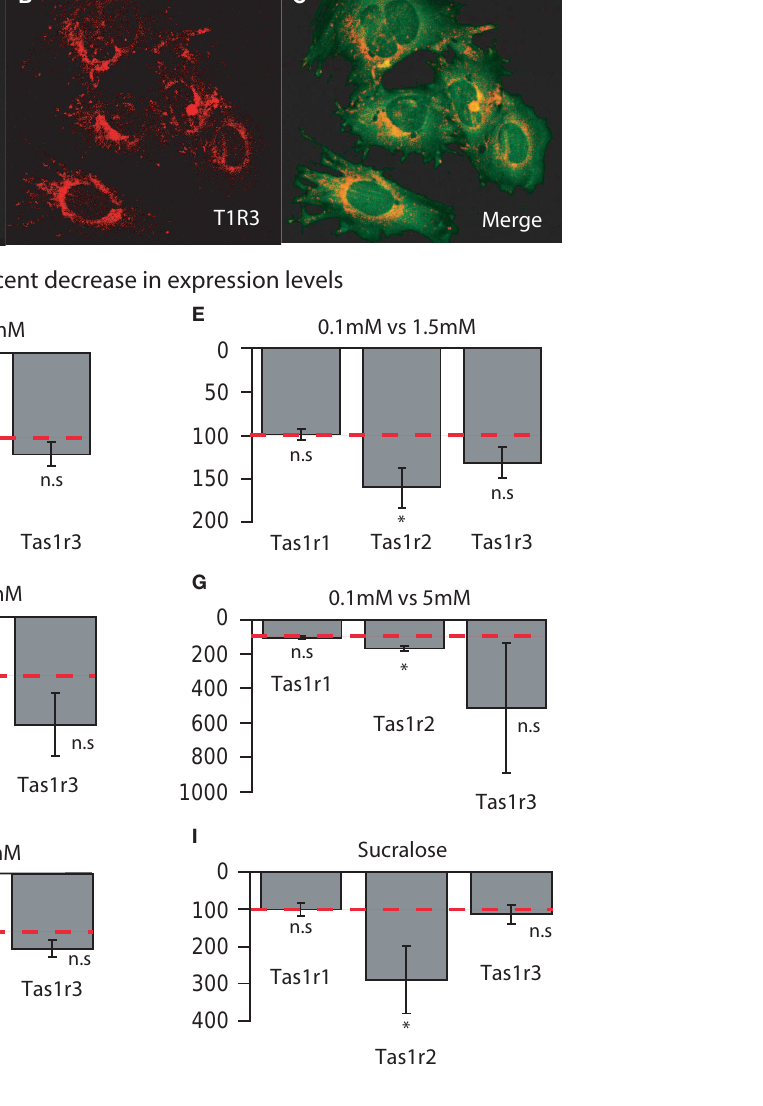
FIGURE 5 | (A–C) Co-expression of taste signaling molecules in the embryonic mouse hypothalamic cell line N38 as assessed by immunofl uorescence methods. Confocal images ( × 10 magnifi cation) of N38 cells that we determine endogenously express taste-related molecules. (A) Expression of the receptor subunit T1R2; (B) expression of the receptor subunit T1R3; (C) merging, showing that these cells express both subunits of the sweet receptor T1R2/T1R3. (D–E) Relative decrease in the levels of expression of the sweet-specifi c receptor gene Tas1r2 in cultured N38 cells as a function of glucose levels in culture medium. The sweet receptor-specifi c gene Tas1r2 , but not others, was found to be expressed at signifi cantly